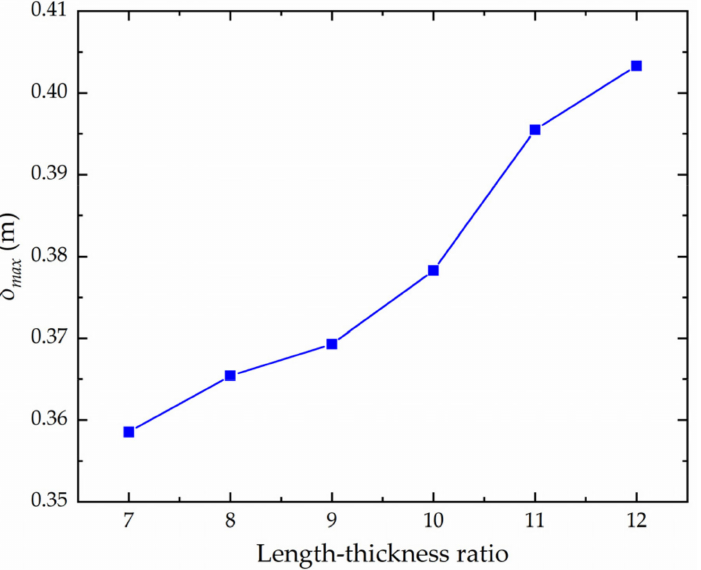
Figure 16. Curve of δ max width-to-thickness ratio for the hexagonal honeycomb